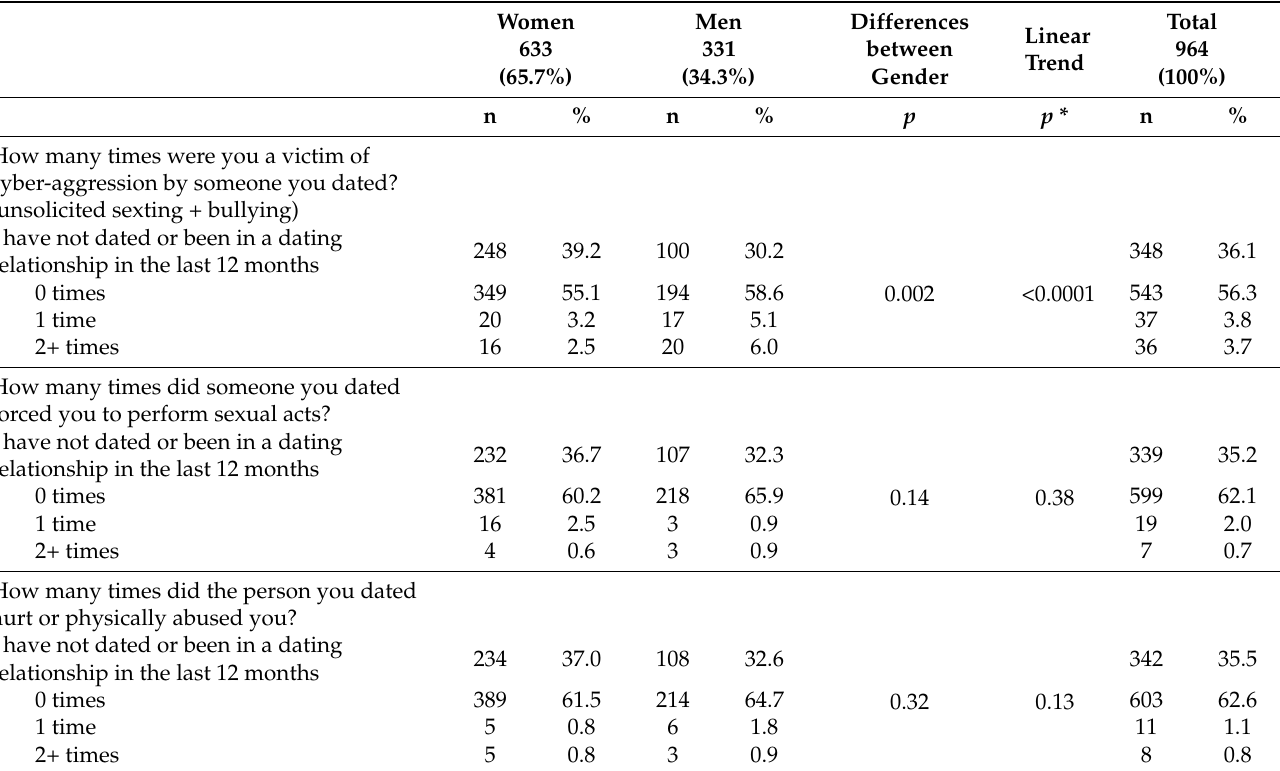
Table 4. Association between sex, frequency of physical and sexual abuse, and cyber-aggression (by his/her dating